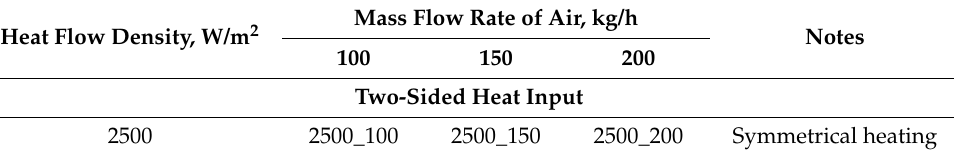
Mass Flow Rate of Air, kg/h 100